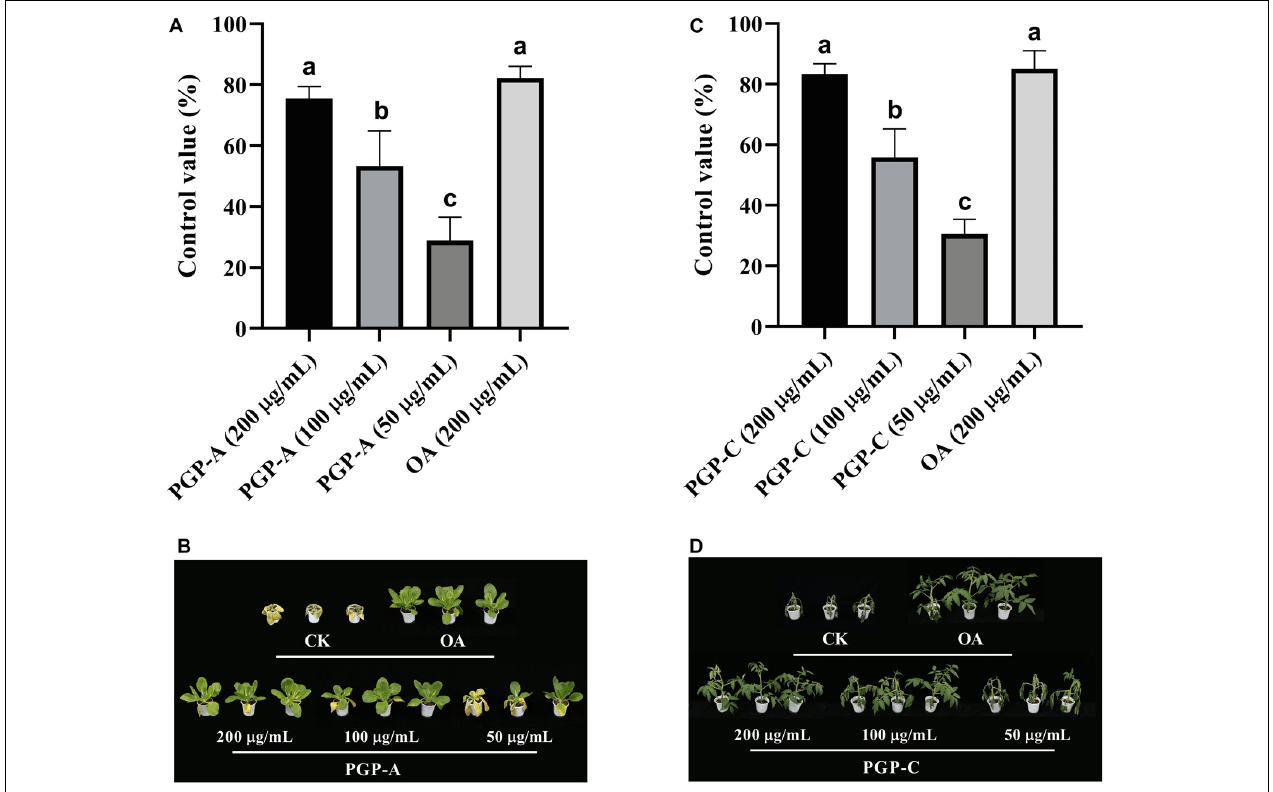
FIGURE 2 | The disease-control efficacy of pelgipeptin (PGP)-A and C on Kimchi cabbage bacterial soft rot (A,B) and tomato bacterial wilt (C,D) , respectively. Each value represents the mean ± standard deviation ( n = 3) of two runs, with three replicates each. Means followed by the same letters above the bars are not significantly different ( p < 0.05) in a Duncan’s multiple range test. OA, oxolinic acid (200 µ